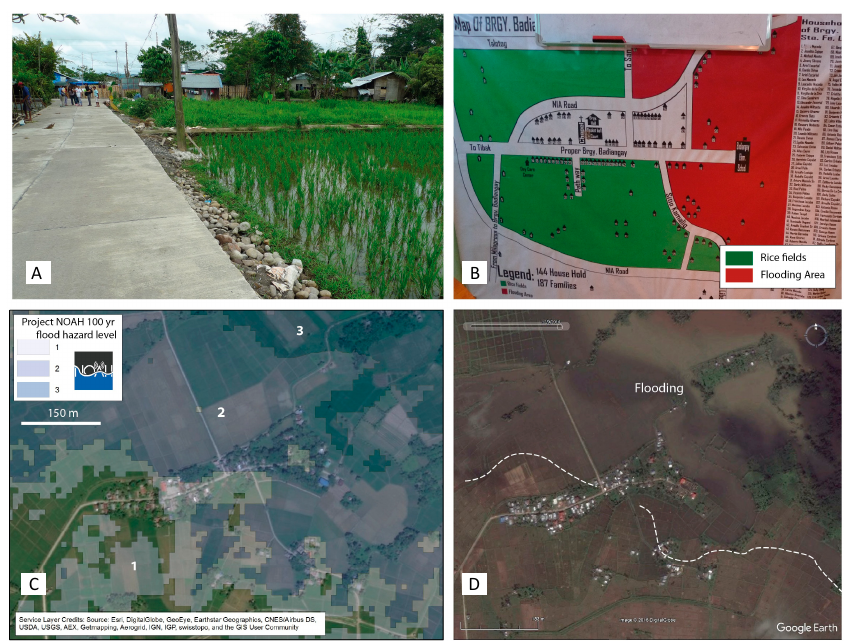
Figure 6. ( A ) Badiangay occupies flat ground along the flood plain of the Bangon River. The main road through the community and the adjacent houses are built upon a narrow strip of artificially elevated ground comprising cobbles, sand, and gravel, which has been brought into the area. ( B ) Community developed map showing areas of flooding based on the community’s experience. ( C ) Project NOAH flood hazard levels associated with a 100-year return rainfall event. Base map provided by ESRI. ( D ) Extent of flooding following heavy rainfall associated with Typhoon Hagupit (2014). DigitalGlobe image captured on 9 December 2014, courtesy of Google Earth.